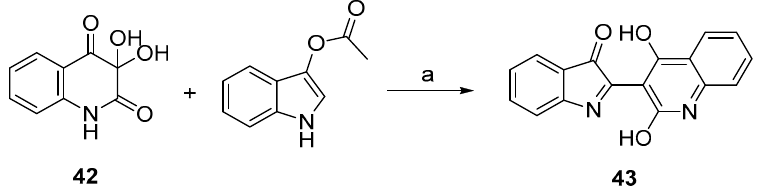
Table 1. Inhibition data of new isatin derivatives 18 – 20 and 23 – 26 .